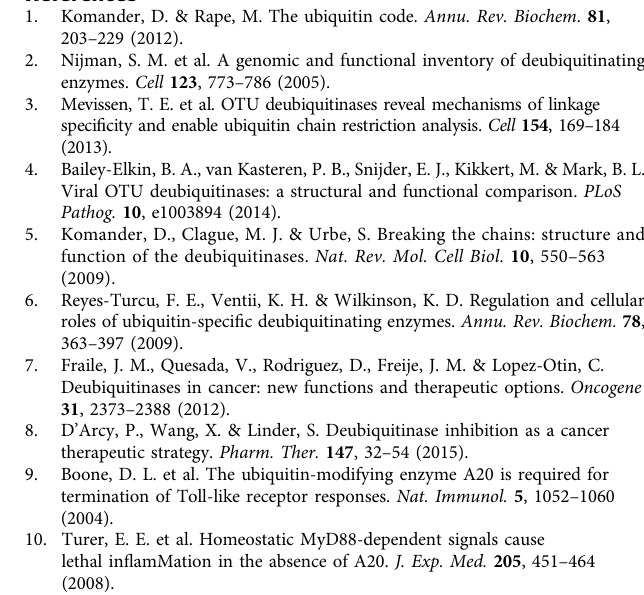
Fig. 8 OTUD5 expression was correlated with clinical features of cancer patients. a OTUD5 depletion promoted colony formation with lung carcinoma cells. b OTUD5 depletion inhibited the expression of PML in H1299 cells and A549 cells. c The levels of OTUD5 (left) and PML (right) mRNA